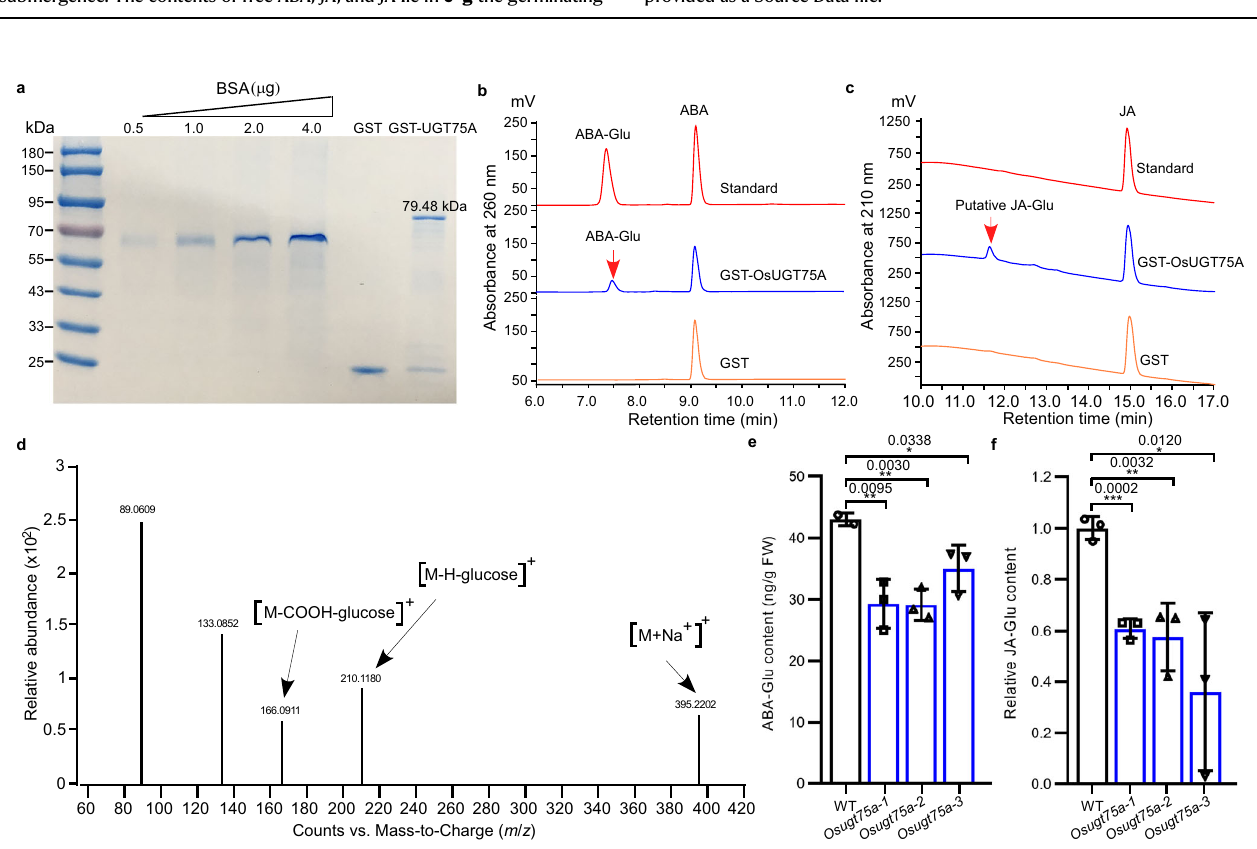
Fig. 3 | OsUGT75A regulates rice coleoptile length under submergence (8cm depthofwater)byin fl uencingabscisicacid(ABA)andjasmonicacid(JA)levels. a , c Representative images ofthe coleoptile length ofWTand Osugt75a mutants in response to 5 and 10 µ M ABA and/or JA treatments after 9 days of submergence. Scale bars represent 10mm. b , d A comparison of coleoptile lengths in WT and Osugt75a mutantsinresponsetocontrol(H 2 O),ABA,andJAtreatmentsafter9days of submergence. The contents of free ABA, JA, and JA-Ile in e – g the germinating